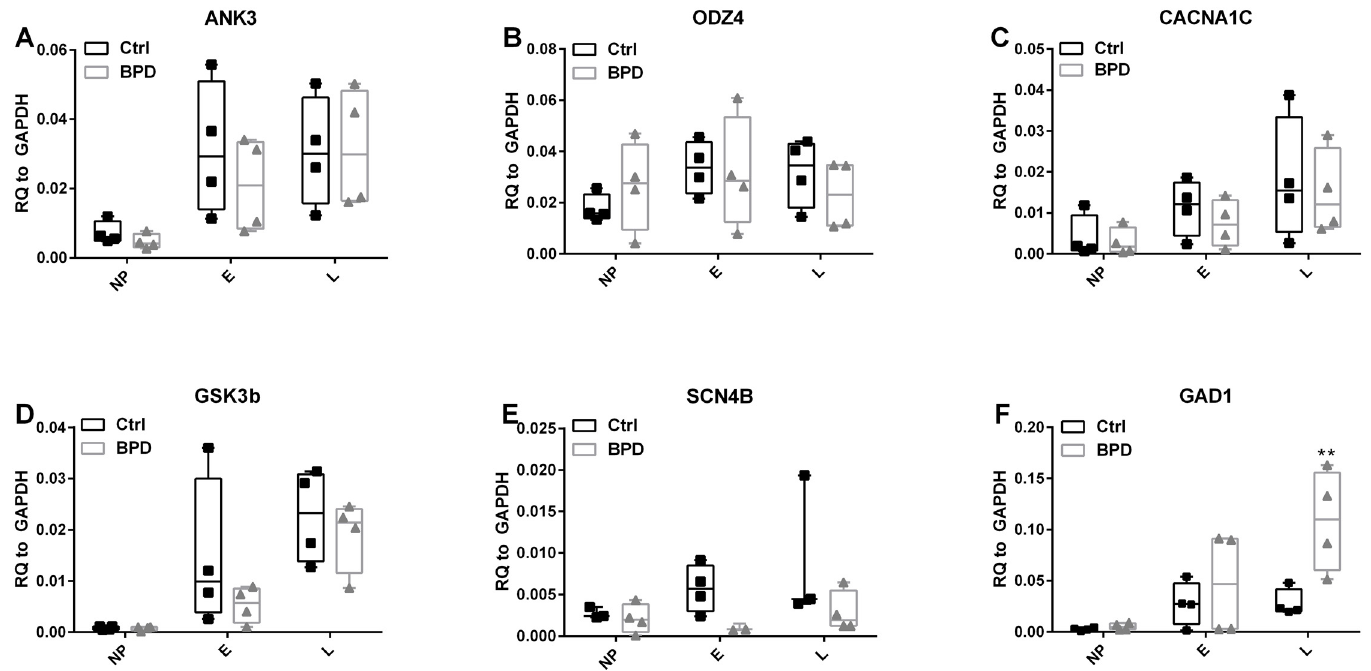
Fig 5. Confirmational quantitative RT-PCR. RNA samples collected during differentiation at NP, E and L neuron stages for microarray studies were analyzed by quantitative RT-PCR. Genes previously implicated to be involved with BPD from genomic studies were evaluated: ANK3, ODZ4 and CACNA1C were analyzed (A-C) and did not show differences in expression at any stage. GSK3B did not show significant differences in BPD and control at any stage (D). SCN4B showed trends of down regulation both in E and L neurons (E), but did not meet the statistical significance. Expression of GAD1 was upregulated in L of BPD compare to control. The box on the plots represents the 25 and 75 percentiles. The horizontal bar within the box represents the median. Individual data points are represented by triangles (BPD) or squares (Controls). n = 4 except for SCN4B NP and L controls and E BPD where n = 3. Two-way ANOVA was performed and Bonferroni ’ s Multiple Comparison post-hoc test was done. ** p < 0.01 when compared to